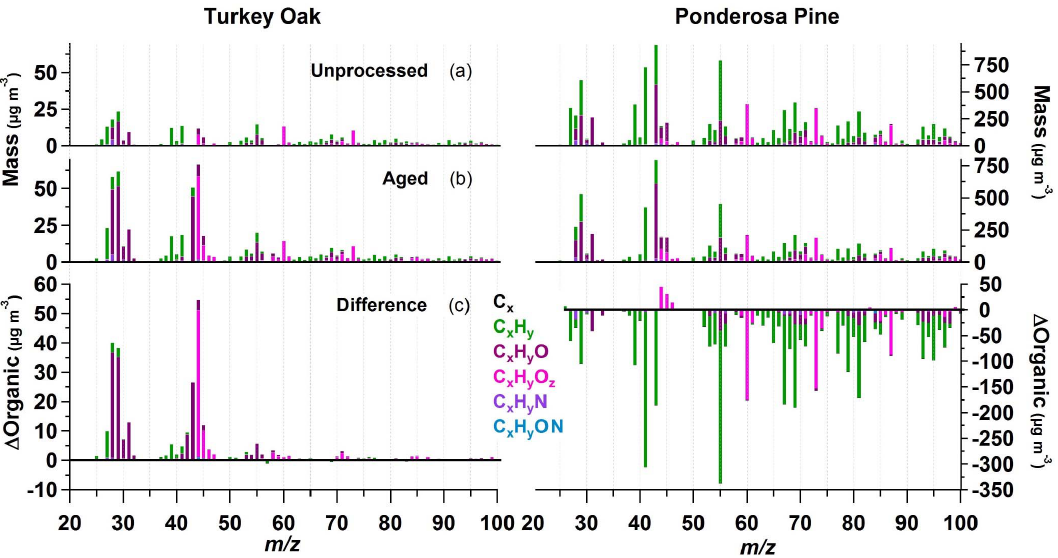
Fig. 9. Effect of photochemical processing on mass spectra of two fuels: turkey oak, burn 45, and ponderosa pine, burn 40. All data were collected 15–25min after the start of fuel combustion and averaged over 10min of sampling with moderate OH exposure. (a) Average mass spectrum of unprocessed smoke, (b) average mass spectrum of aged smoke, and (c) difference ( 1 OA) between aged and unprocessed smoke. All plots are colored by ion